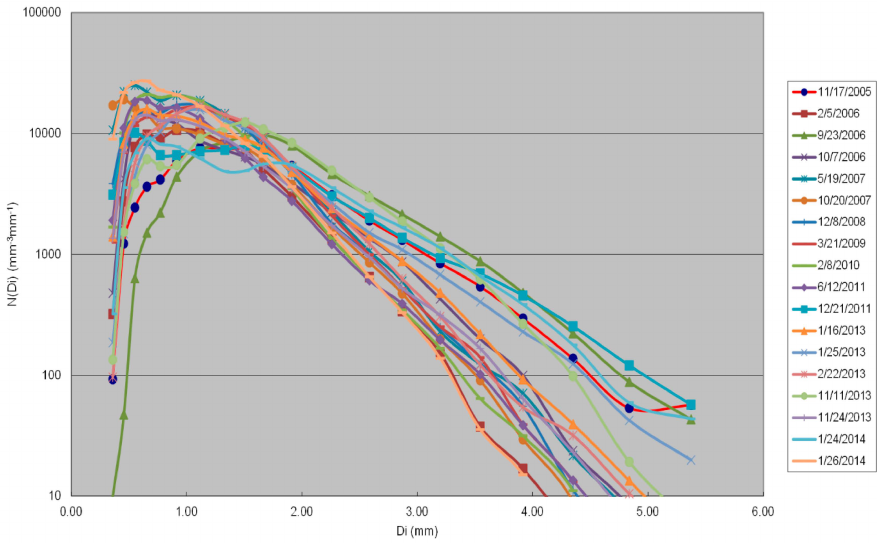
Figure 3. The DSDs of the 18 convective